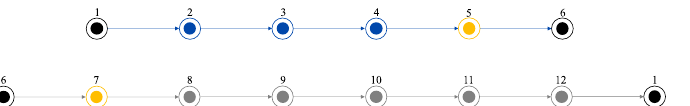
Figure 5. Bus stops scheme for line 15. Initial and final stops (black points) for outward ( top ) and return ( bottom ) journeys; intermediate stops for outward journey (blue); intermediate stops for return journey (grey); common stop for outward and return journey (yellow).